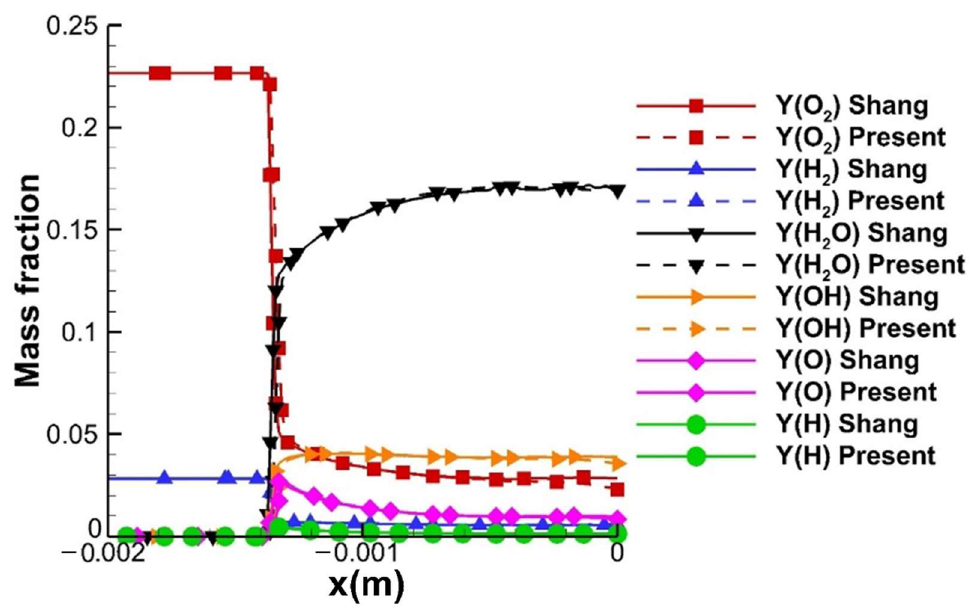
Figure 18. Mass fraction of hydrogenous and oxygenous species distribution along the stagnation line of the super-detonative combustion.